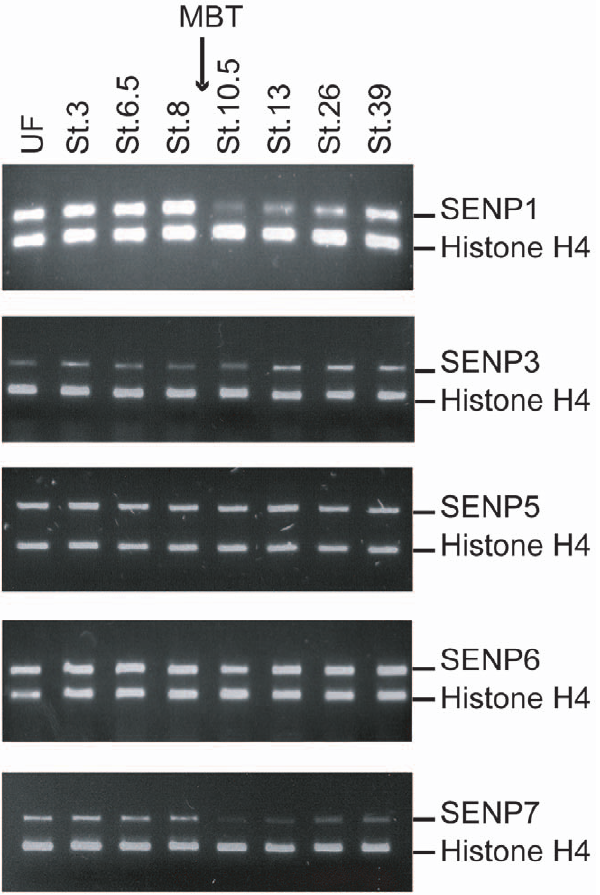
Figure 2. RT-PCR assay showed that mRNA levels for different SENPs family proteins vary during developmental stages. Total RNA from whole animals at the indicated stages was analyzed by RT- PCR using specific primers for different SENPs and Histone H4 (control). The interval corresponding to the midblastula transition (MBT) is indicated by the arrow. UF indicates samples from unfertilized eggs, while individual stages are indicated numerically, proceeded by the abbreviation